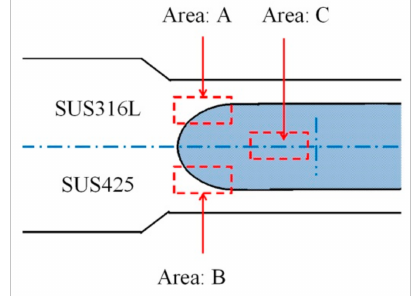
Figure 11. Schematic of area-specific microstructure